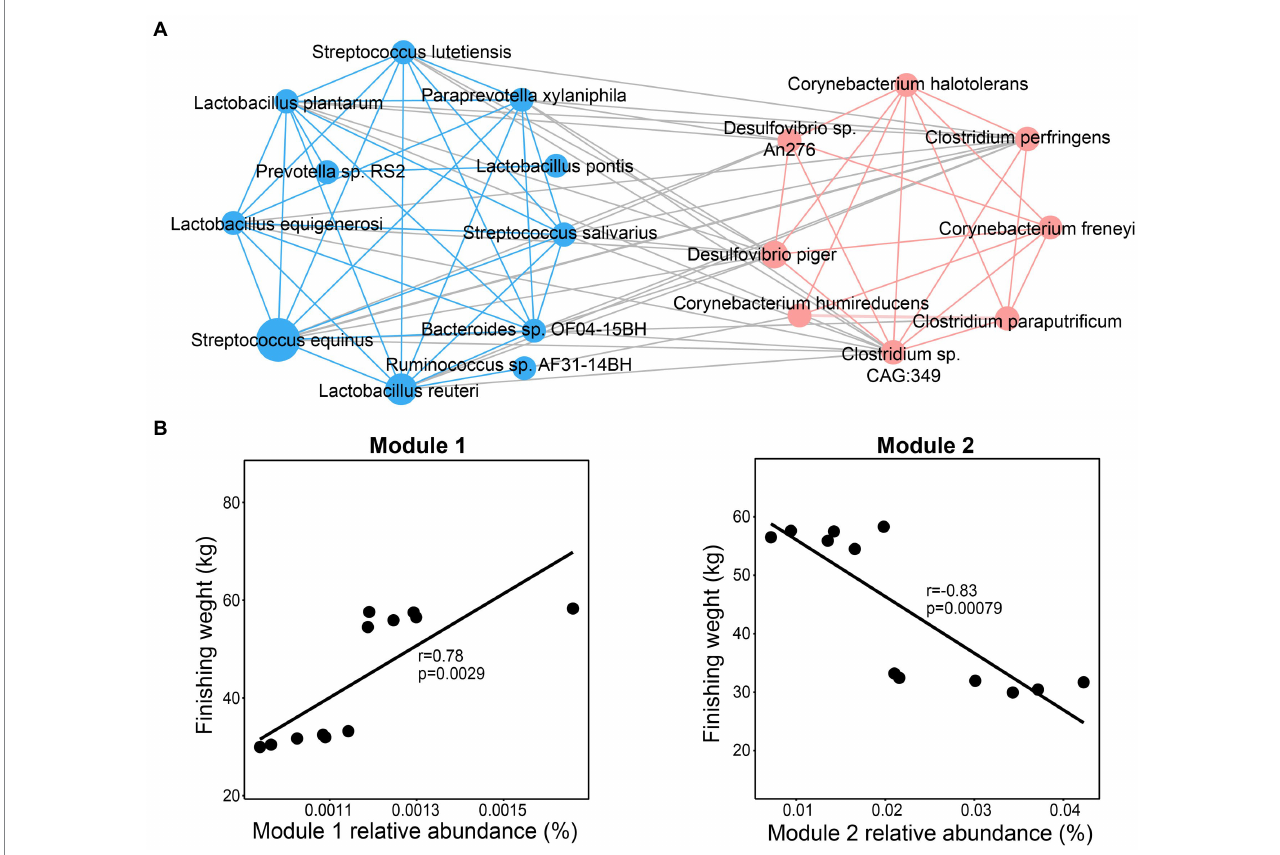
FIGURE 4 Interactions among the species responding for finishing weight. (A) The interaction network among finishing weight-related species. The blue nodes and lines, respectively, denote positively associated species and positive correlations among them. The coral nodes and lines, respectively, represent negatively associated species and positive correlations among them. Lines with gray color indicate a negative correlation. The node size was drawn according to the average relative abundance of different species. Each line linked to nodes represents significant correlations (FDR adjusted p < 0.05, | r | > 0.65). (B) The associations of the abundance of Module 1 and Module 2 with finishing